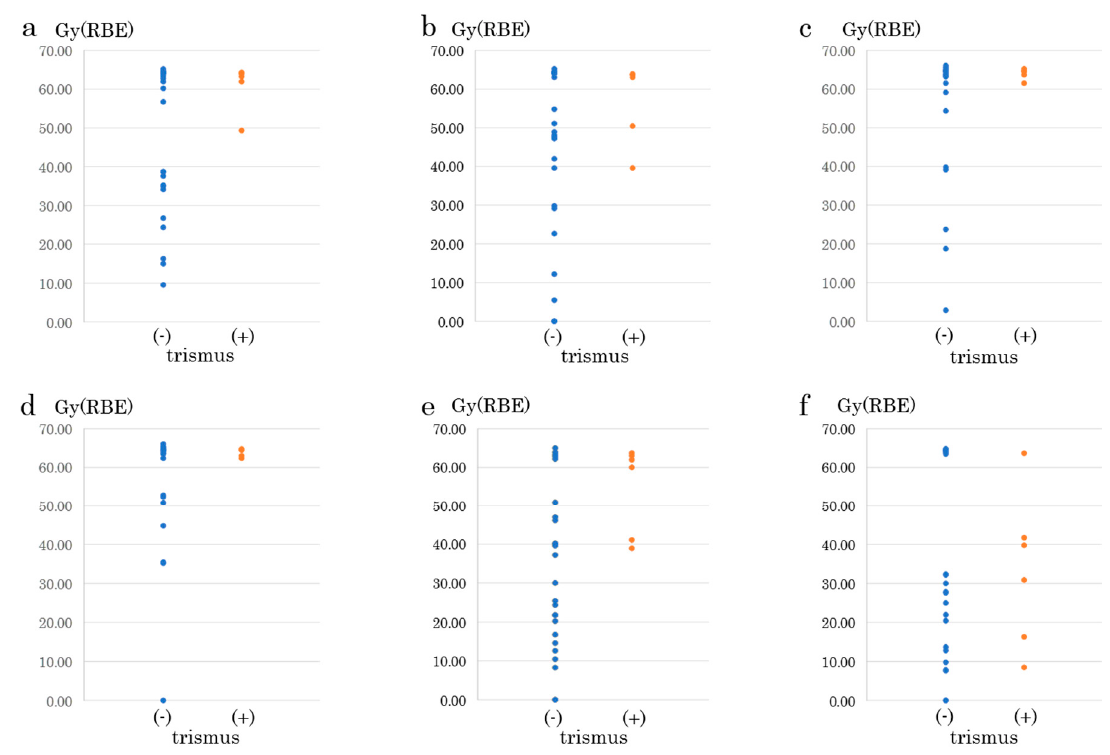
Figure 4. Relationship between maximum dose in the temporomandibular joint-related structures and carbon ion radiotherapy-induced trismus. Data are presented as mean ± S.D. ( a ) Masseter muscle, ( b ) temporal muscle, ( c ) medial pterygoid muscle, ( d ) lateral pterygoid muscle, ( e ) coronoid process, ( f ) mandible head. Table 1. Cut-off value of maximum dose for the onset of trismus in temporomandibular joint-related organs.